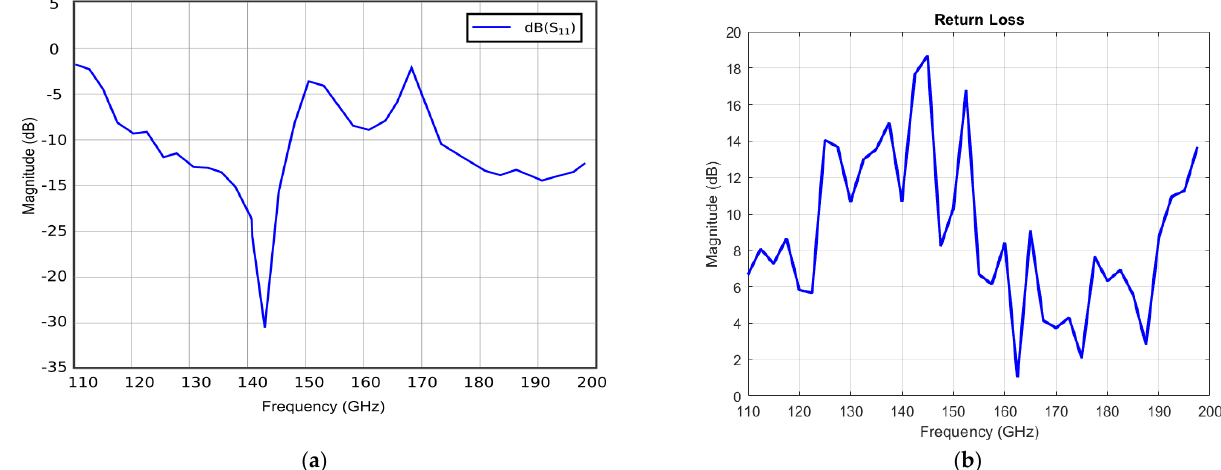
Figure 18. Minkowski fractal antenna for 4 iterations: ( a ) Self-reflection coefficient S 11 , ( b ) Return loss.